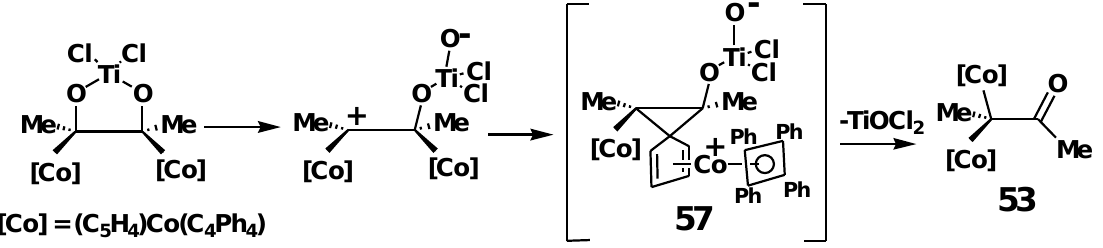
[Co] = (C H )Co(C Ph ) 5 4 4 4 Scheme 17. Pinacolone formation in a McMurry reaction of (C 4 Ph 4 )Co[C 5 H 4 C(=O)Me].